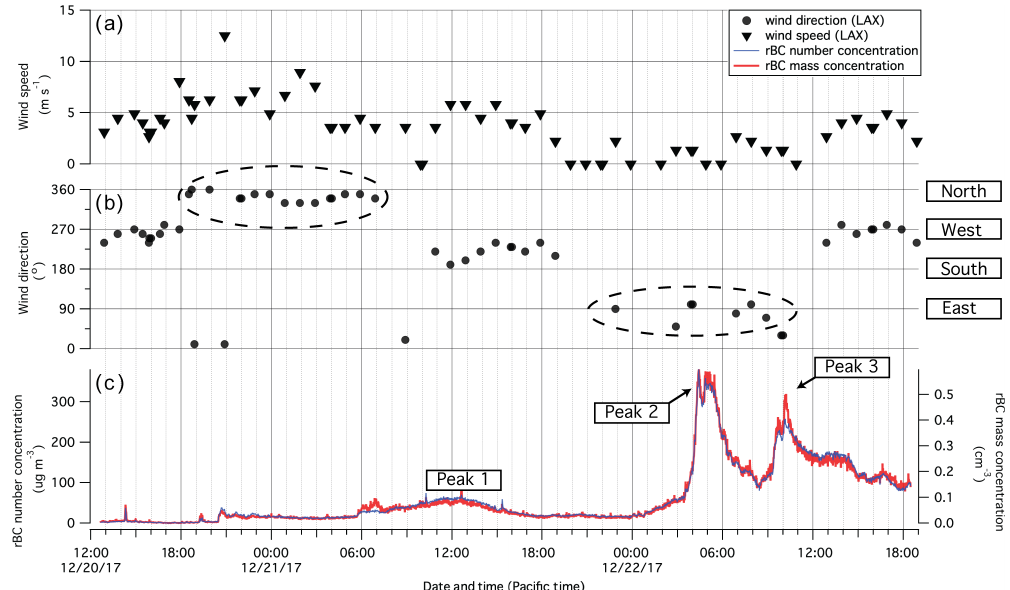
Figure 5. Meteorological variables and rBC concentrations during the second campaign (December 2017). Panel (a) shows wind speed and panel (b) shows the wind direction measured by a NOAA weather station located at Los Angeles International Airport (LAX). Panel (c) shows the rBC mass and number concentrations and identifies three peaks of interest. The two dashed ovals in panel (b) highlight periods of northerly and easterly winds, which occur ∼ 0 . 5–1d before each of the three peaks, suggesting that the elevated rBC concentrations included important contributions from the local Thomas Fire (and other smaller fires) and urban emissions from the Los Angeles Basin. Dates on the x axis are given in the following format: